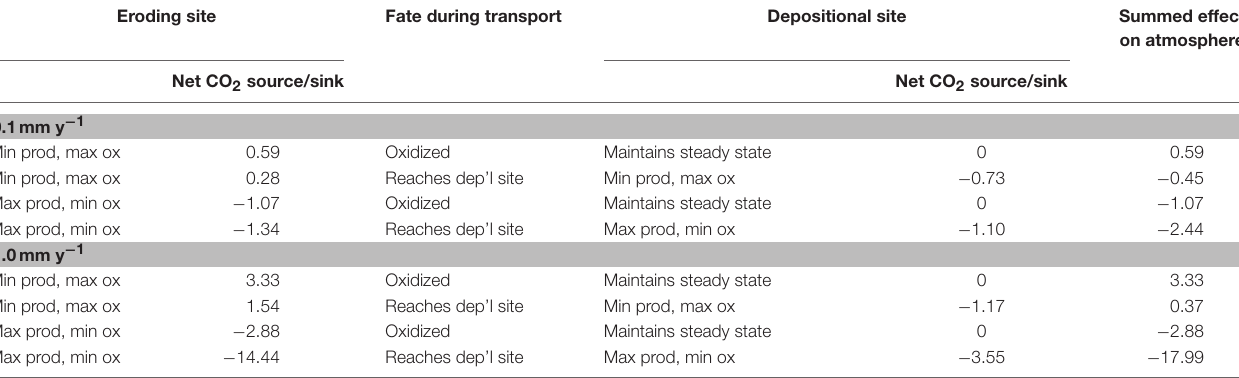
TABLE 3 | Warm temperate forest eroding and depositional sites’ net CO 2 source (+) or sink (-) strengths, and their summed effects on the atmosphere, assuming that initial depth of both profiles was 1.0 m. Eroding site Fate during